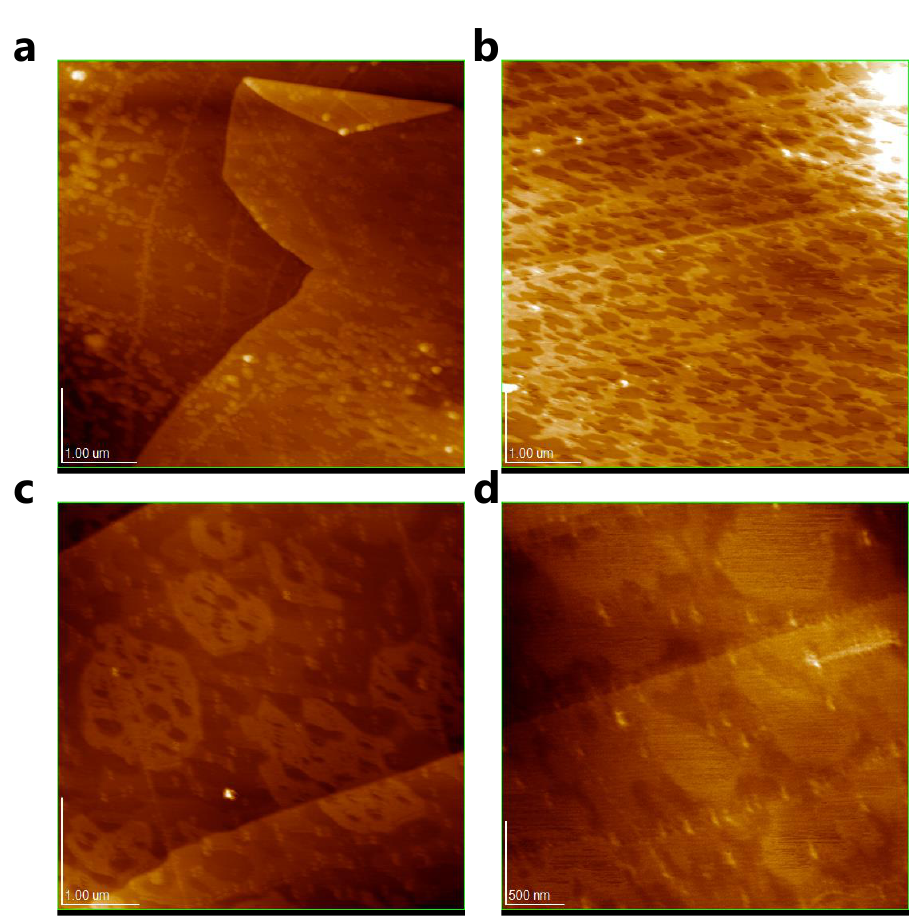
Figure 3. ( a – d ) Typical AFM images of porphyrin polymer (over-900 mer) on the HOPG surface collected using tapping mode under ambient conditions.